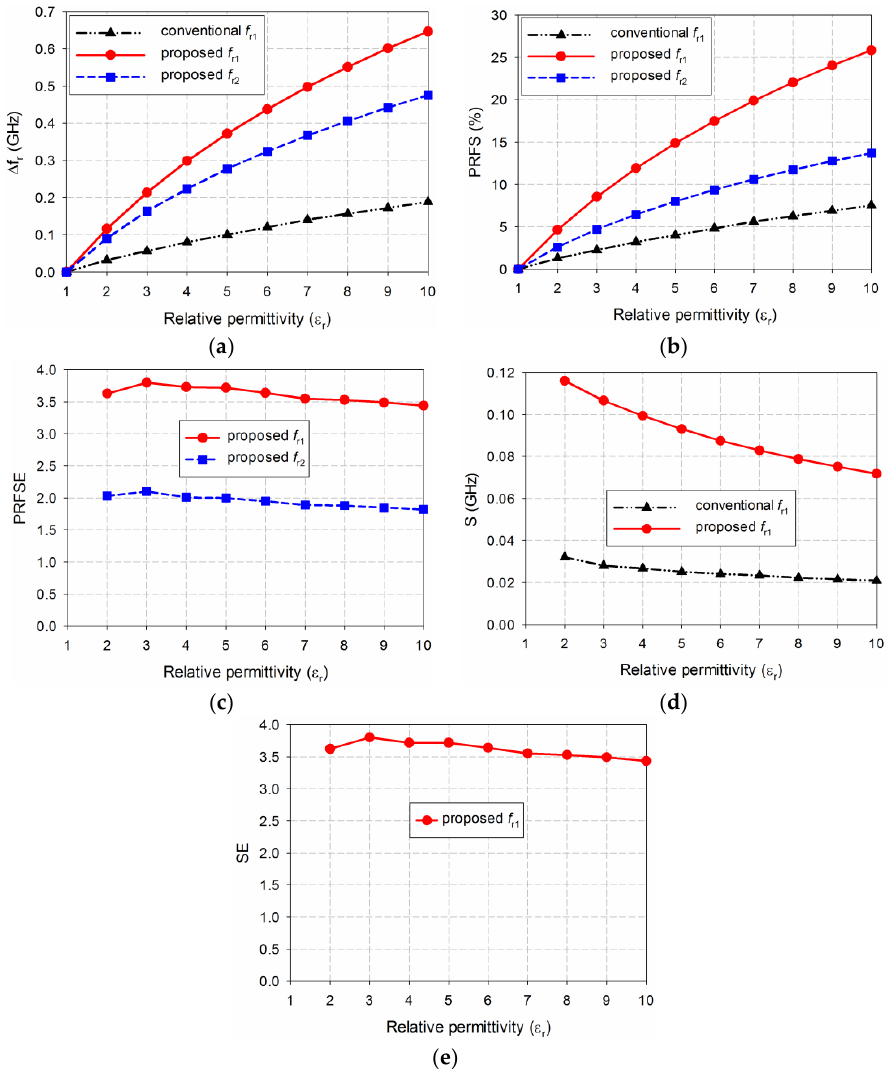
Figure 6. Sensitivity comparison of the conventional and proposed patch antennas: ( a ) Resonant frequency ( Δ f r ); ( b ) percentage relative frequency shift (PRFS); ( c ) enhancement in percent relative frequency shift (PRFSE); ( d ) sensitivity (S); ( e ) sensitivity enhancement (SE).